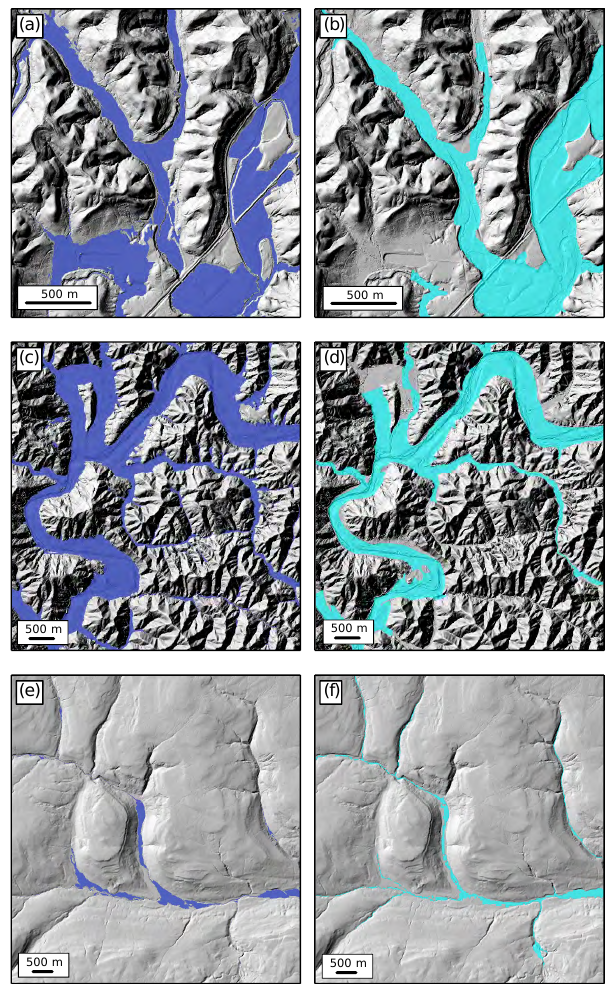
Figure 6. Shaded relief maps for each field site showing a compar- ison between the predicted floodplains (a, c, e) and the published FEMA/EA maps (b, d, f) . (a–b) Mid Bailey Run, OH. (c–d) Rus- sian River, CA. (e–f) River Swale,